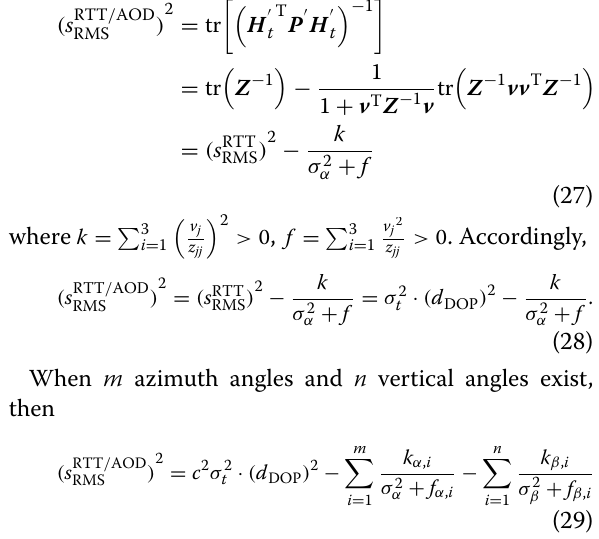
Table 3 Statistical results of Multi-RTT and RTT/AOD positioning errors in a good environment Complex